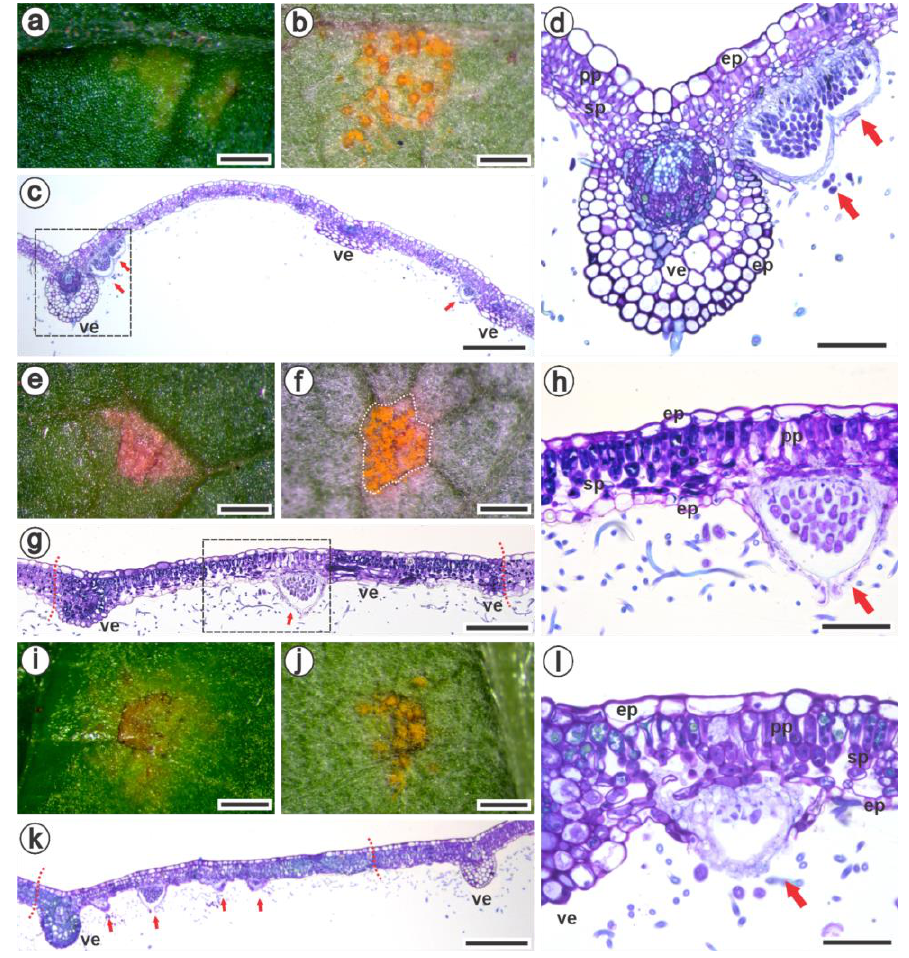
Figure 4. Morphoanatomy of lesions on the leaf blades of Rubus idaeus cv. Autumn Bliss ( a – d ), R. occidentalis ( e – h ) and R. niveus ( i – l ) caused by Aculeastrum americanum 14 days after inoculation. The visual symptoms are characterized by chlorotic ( a ) or necrotic ( e , i ) lesions on the adaxial surface, and correspond to the uredinia on the abaxial surface ( b , f , j ). Cross-sections of the lesioned area are shown in general view, dotted box in ( c , g , k ) and as the respective highlighted sectors ( d , h , l ). The uredinia are limited by the veins ( f , g , j , k ) only in R. occidentalis and R. niveus , and the mesophyll cells are intensely stained blue/greenish-blue by the accumulation of phenolic compounds ( h , l ). The yellow spots outside the vein correspond to released urediniospores ( j ). Pustules are indicated with arrows. ep, epidermis; pp, palisade parenchyma; sp, spongy parenchyma; ve, vein. Bars: ( a , b , e , f , i , j ): 0.5 mm; ( c , g , k ): 500 µ m; ( d ): 100 µ m; ( h , l ): 50 µ